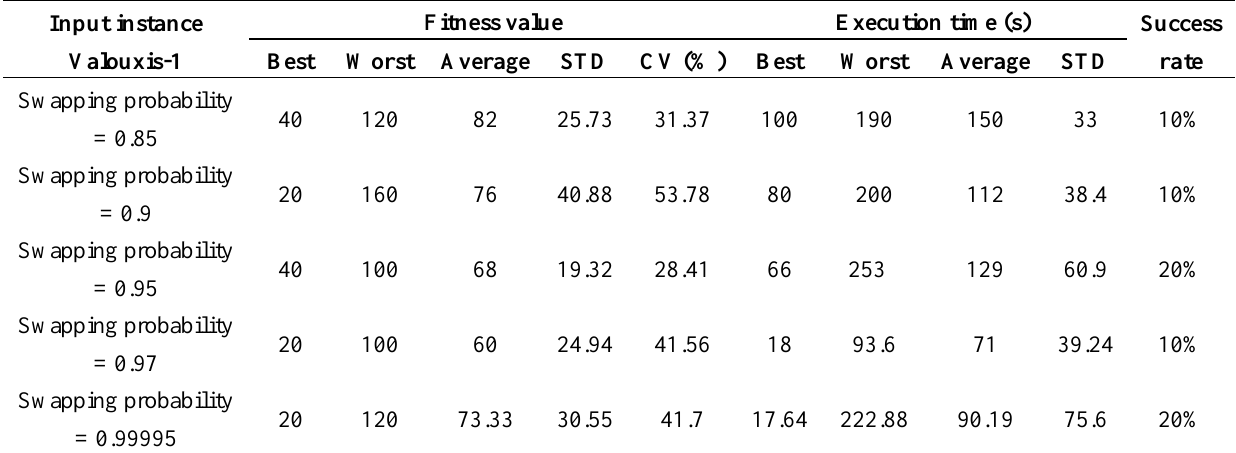
Table 7. Investigating the effect of swapping probability for input instance, Valouxis-1.